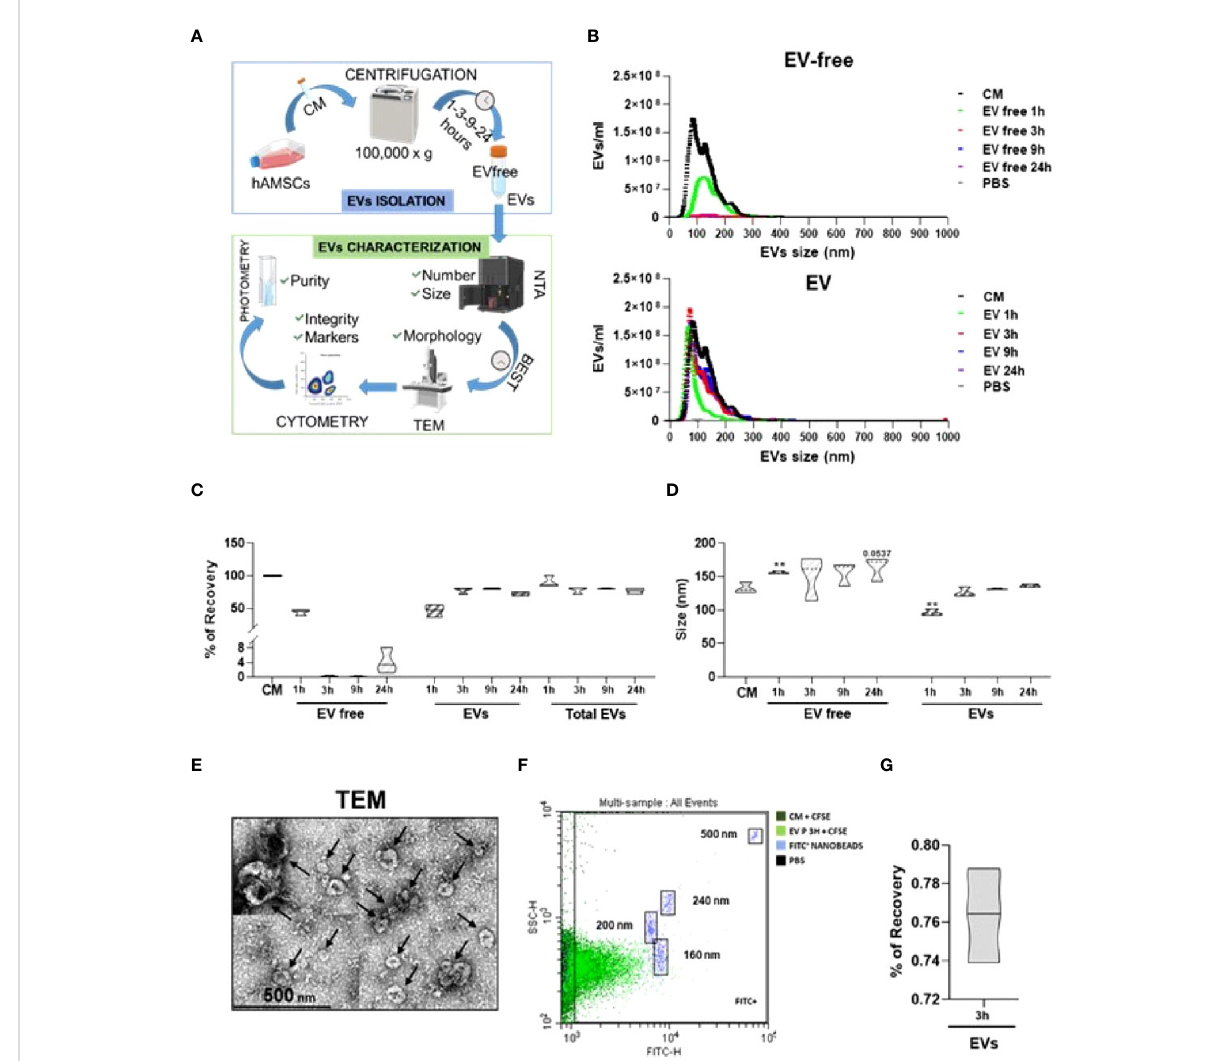
FIGURE 1 De fi nition of hAMSC-CM fractionation protocol and EV characterization. (A) Work fl ow of the protocol used to identify and validate the most ef fi cient centrifugation procedure to obtain EV-depleted and EV-enriched fractions from hAMSC-CM. (B) Particle size and concentration pro fi les from NTA data for both fractions (EV free and EVs) after centrifugation for the indicated times (1, 3, 9, and 24 h). CM and PBS were used as starting condition and background, respectively (N = 3, values indicated as mean ± SD). (C) EV recovery or contamination in the EV-free fraction for the tested centrifugation times (1, 3, 9, and 24 h) calculated from the NTA data with respect to EVs in the CM set as 100% (N = 3, mean ± SD). (D) Size analysis from NTA data for the EVs identi fi ed in the CM, EVs, or EV-free fractions obtained after centrifugation for the indicated times (1, 3, 9, and 24 h) (N = 3, mean ± SD). (E) Transmission electron micrographs of EVs in the 3-h centrifugation pellets showing characteristic cup-shaped morphology and size compatible with NTA data. Black arrows indicate the EVs. (F) Visualization of EVs (in